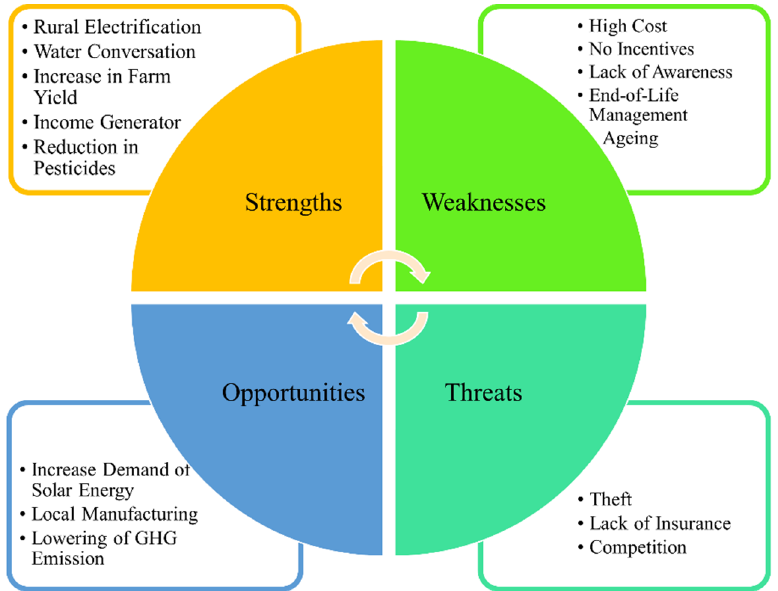
Figure 10. Factors identified in the SWOT (Strength, Weakness, Opportunity, and Threat) analysis.